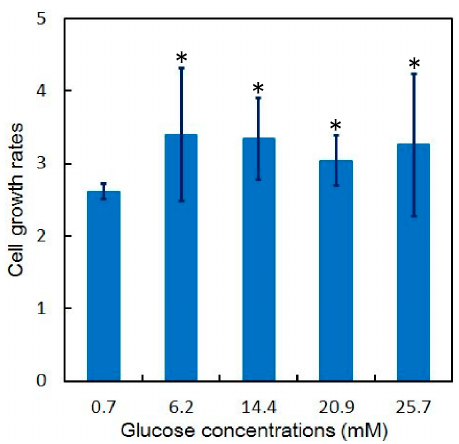
Figure 15. Growth rate of HeLa cells in discrete cell culture microchambers ( n = 3); * p < 0.05 ( t -test) in 0.7 mM.